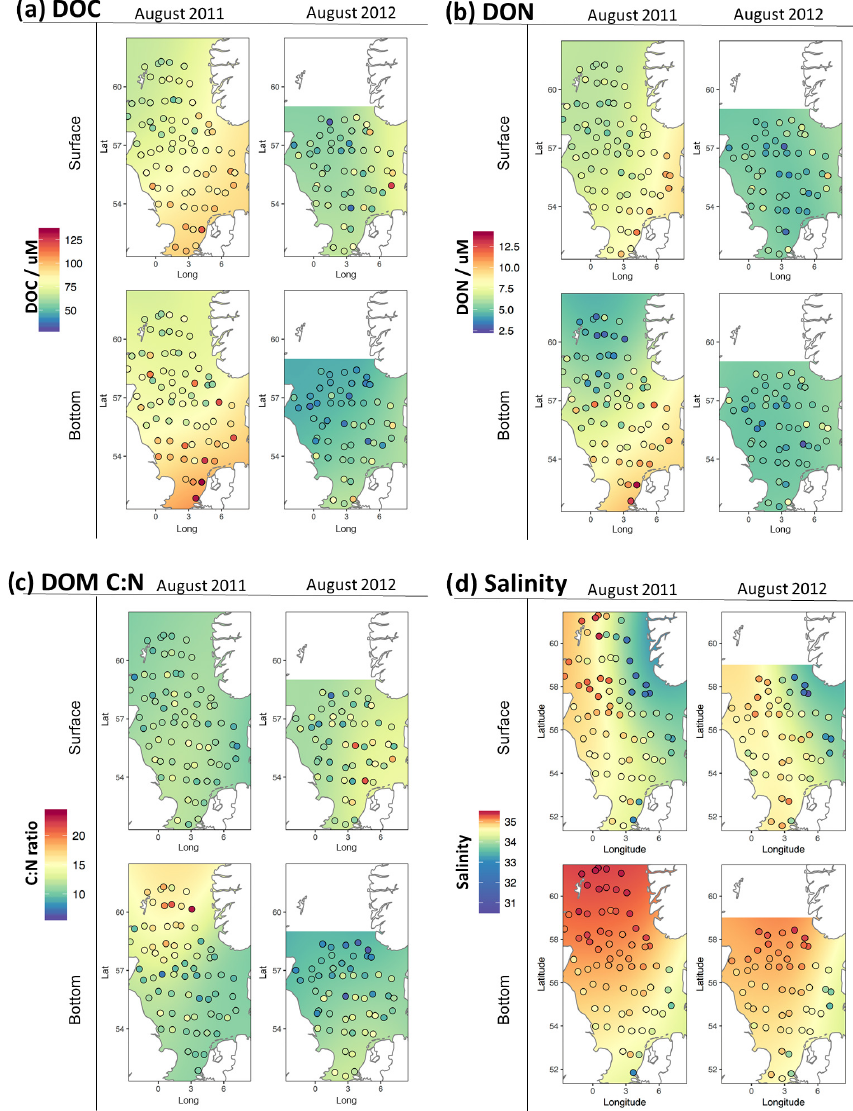
Figure 5. Distribution of (a) DOC, (b) DON, (c) C : N ratio of DOM and (d) salinity for surface and bottom waters in summer 2011–2012. Points represent discrete observations and the underlying colour gradient is a two-dimensional Gaussian smooth of the discrete data to demonstrate the spatial